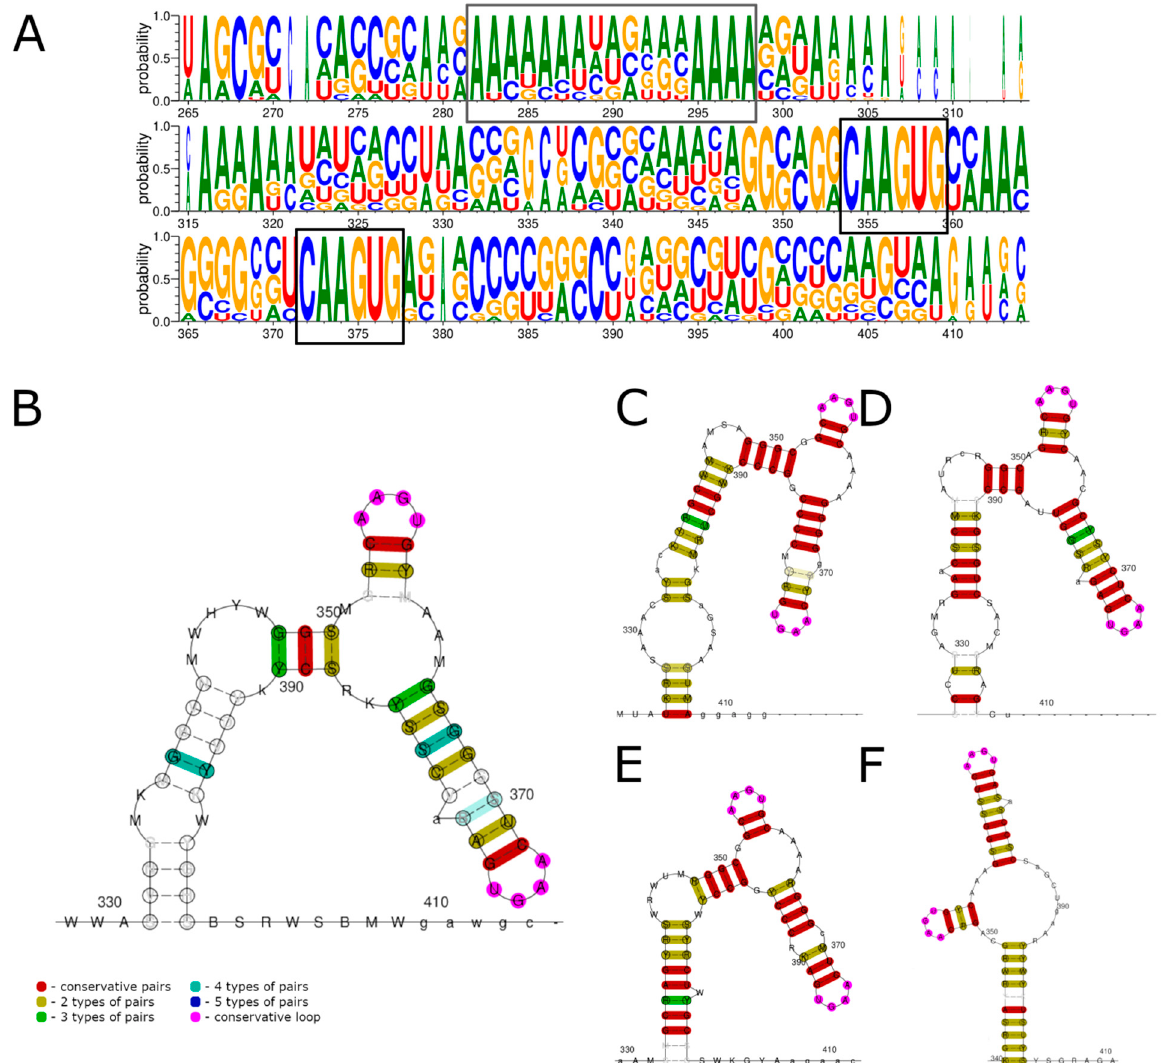
Figure 3. Consensus sequences and conserved RNA structures of 3 (cid:48) UTRs of ALSV and YGTV studied in this work predicted using LocARNA. ( A ) Consensus sequences of all segments of ALSV and YGTV 3 (cid:48) UTRs. ( B ) Conserved RNA structures of all segments of ALSV and YGTV 3 (cid:48) UTRs. Conserved RNA structures of segments one ( C ), two ( D ), three ( E ), and four ( F ). Conserved nucleotides in the consensus sequences are marked by black boxes. Nucleotide enumeration in ( B – F ) follows the enumeration in the alignment ( A ).